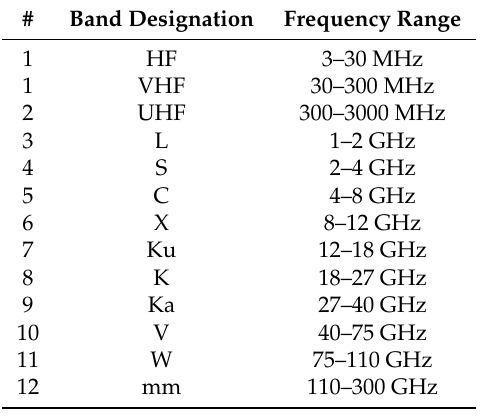
Table 4. Radar frequency bands according to IEEE standards.